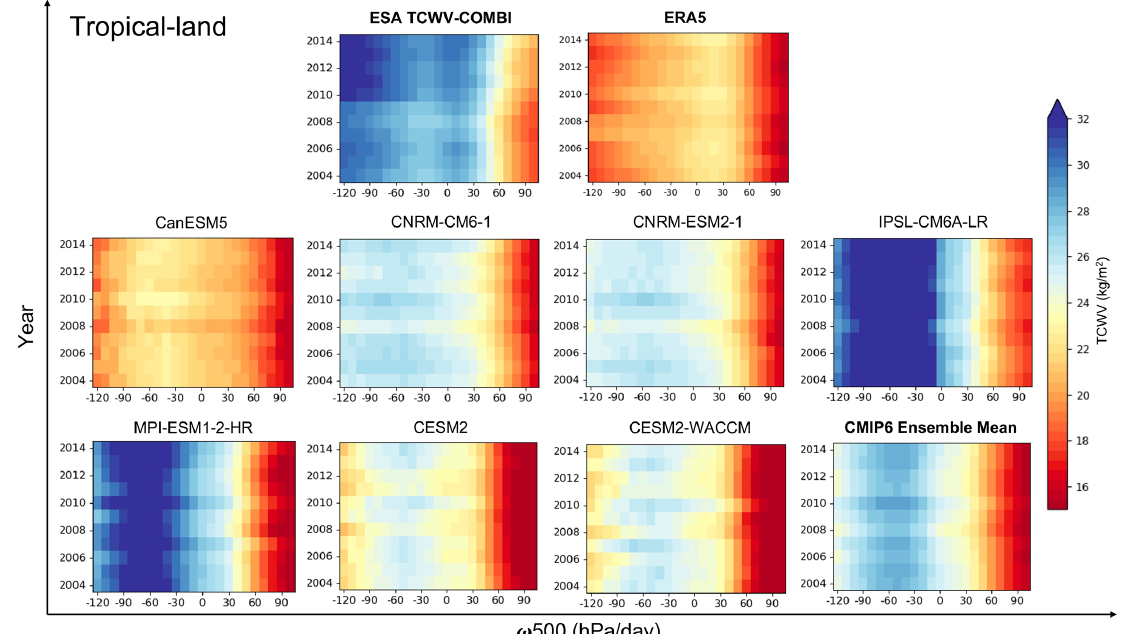
Figure 8. Mean of TCWV over tropical-land areas at each dynamical interval ( ω 500) in 10hPad − 1 computed from each data record.